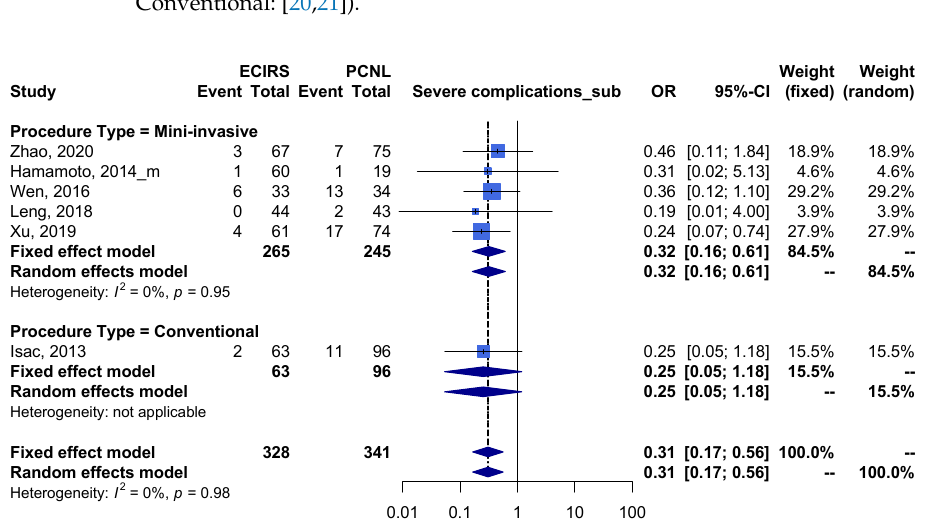
Figure A4. Subgroup analysis of outcome regarding severe complications. (Mini: [17–19,22,23]; Conventional: [21]).